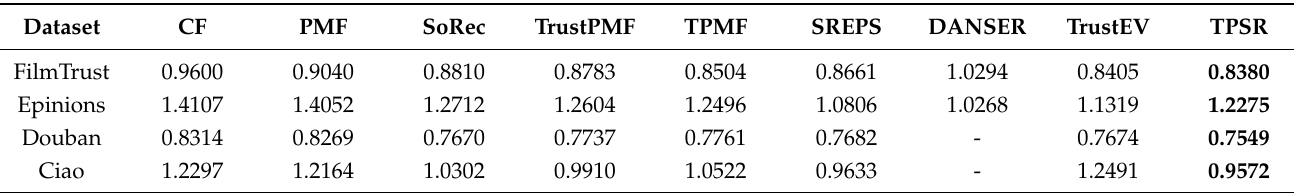
Table 4. Rating Prediction Accuracy RMSE Experiment.